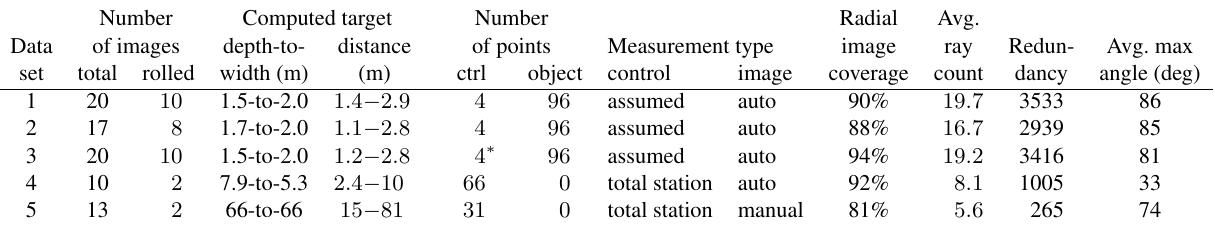
Table 2: Statistics about the measurements of each data set. The target depth-to-width and distance values are computed with respect to a stationary camera, i.e. as if the calibration object was moving. The reported redundancy value is the number of observation minus the number of unknowns. The average max angle is the average of the maximum intersection angle of the observation rays for each target. ∗ In data set 3, the control point coordinates were used by the resection process only. For details, see the